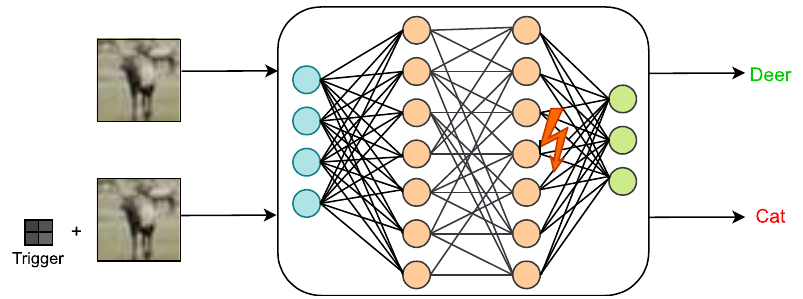
Figure 12. Bit flip based attack Trojan